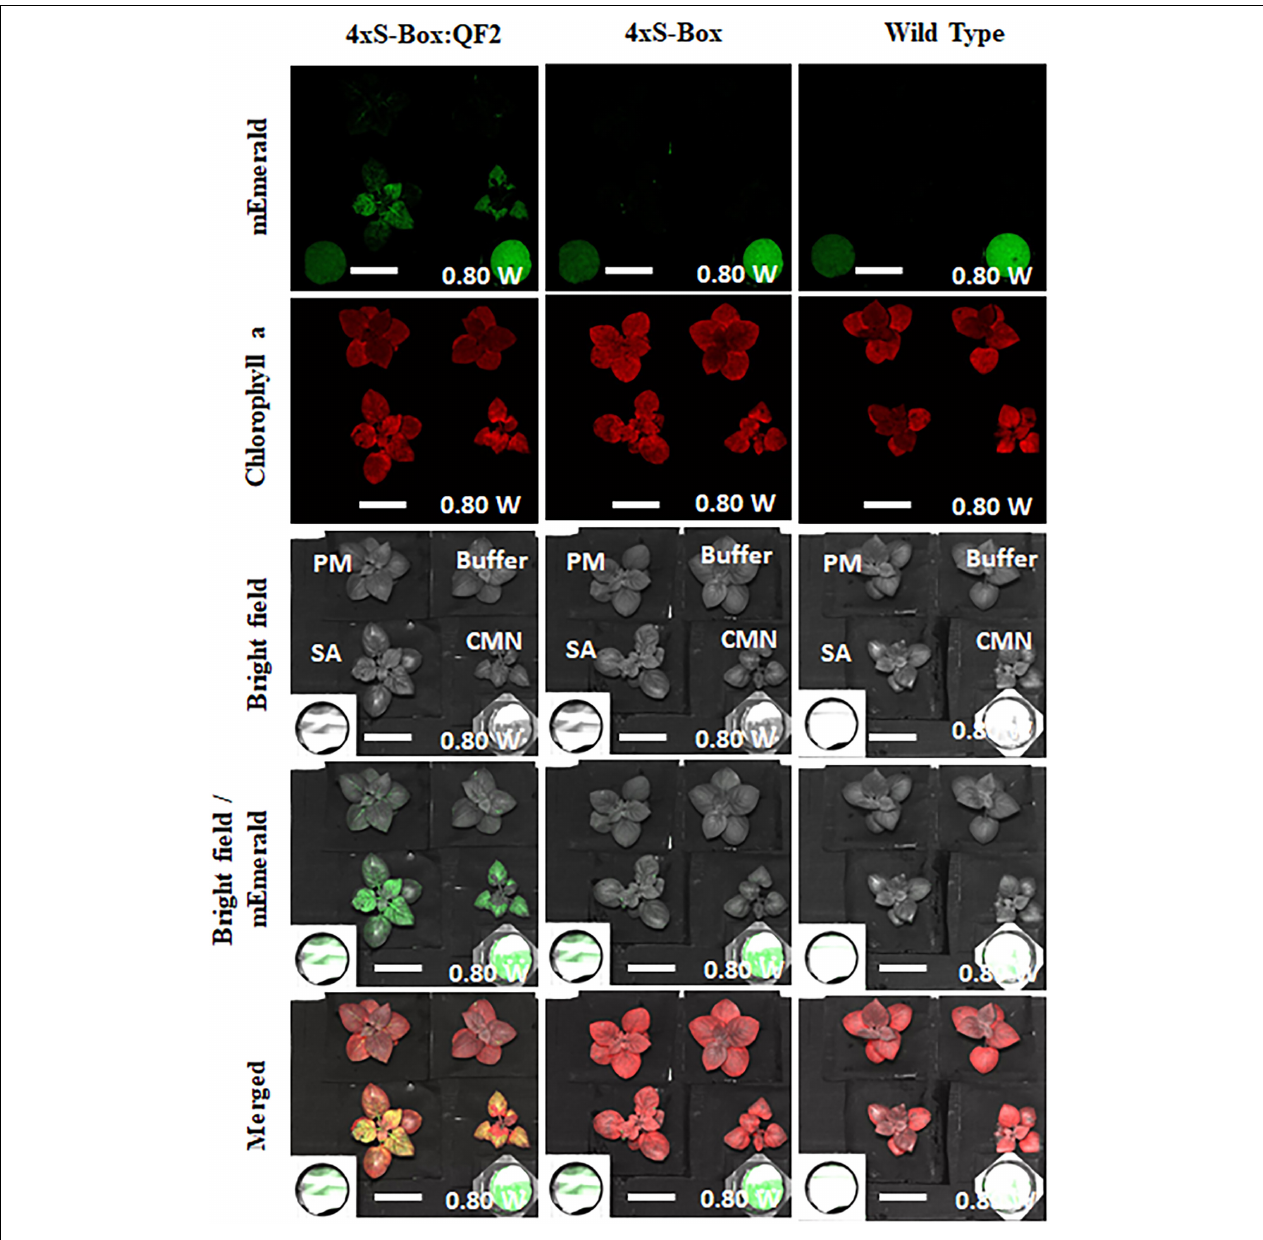
FIGURE 7 | Detection of fluorescence in phytosensors for standoff detection application. Images acquired using the fluorescence-induced laser projector (FILP) system. FILP images showing detection of fluorescence in pathogen phytosensors with the Q-system. In total of 4xS-Box:QF2 (with Q-system), 4xS-Box (without Q-system), and wild-type plants were inoculated with bacterial pathogens Clavibacter michiganensis subsp. nebraskensis (CMN), Streptomyces acidiscabie (SA), Pseudomonas marginalis (PM), and 10 mM MgCl 2 (mock-control). Plants were infiltrated with a bacterial inoculum of OD 600 = 0.3, corresponding to colony forming units (cfu) of 3 × 10 8 cfu/ml CMN, 3 × 10 8 cfu/ml SA, and 1 × 10 8 cfu/ml PM. Three independent experiments with four biological replicate plants ( n = 4) per experiment was performed. Images representative of one independent line per construct. Images show the ability to detect mEmerald at 72 h after bacterial inoculation. Pixel intensity at 0 h (before treatment) was subtracted to normalize against background emission before treatment. Images processed with imageJ using the same brightness and contrast settings. The fluorescent images were acquired at a distance of 3 m from laser source with 200 ms exposure time at 0.80 watts laser power. mEmerald GFP images were acquired using the 465 nm excitation laser and the 525/50 nm emission filter. Chlorophyll images were acquired using the 465 nm excitation laser and the 680/50 emission filter. Scale bar: 5